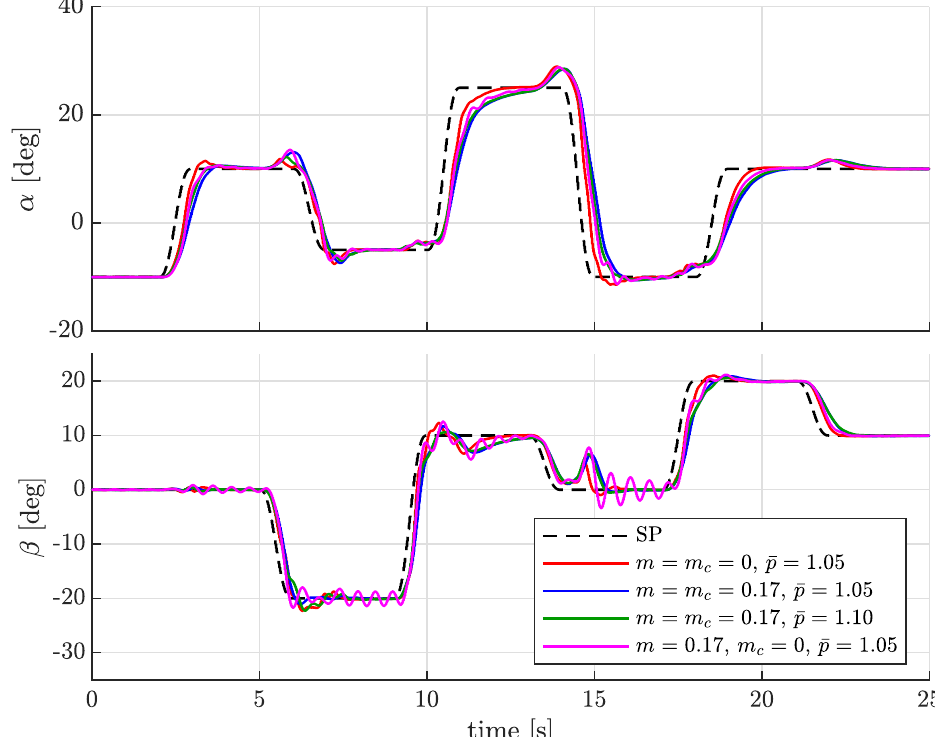
Figure 16. The resulting tracking performance when relying on the feedback controller is shown in the top plot for α and in the bottom plot for β . The black dashed lines denote the set point trajectories and the colored lines the four cases investigated. Thereby, the following parameters are changed: the attached payload mass, m , the value set for the payload mass in the controller, m c , and the lower pressure level ¯ p . Normally, the two values for m and m c are identical, but for the sake of this investigation, we also consider differing values. The red line shows the results when no payload mass is attached and the joint stiffness is set to the lower level ( ¯ p = 1.05bar) and the blue line shows the case where a payload mass is attached and the joint stiffness is set to a low level. The green line represents the case where a payload mass is attached and the joint stiffness is set to the high level ( ¯ p = 1.10bar). For all three cases, the controller had knowledge of the true payload mass attached ( m c = m ), resulting in similar tracking performance for both α and β . The purple line indicates the behavior when a payload mass is attached ( m = 0.17kg), but the controller assumes no payload mass ( m c = 0). The joint stiffness is set to the lower level for this case. Distinct oscillations are visible for the last case, when considering β . As a consequence of the mismatch between the true mass and the value commanded to the controller, the control performance is degraded. Additionally, note the slight errors occurring in one angle, when commanding a change in the other angle and vice